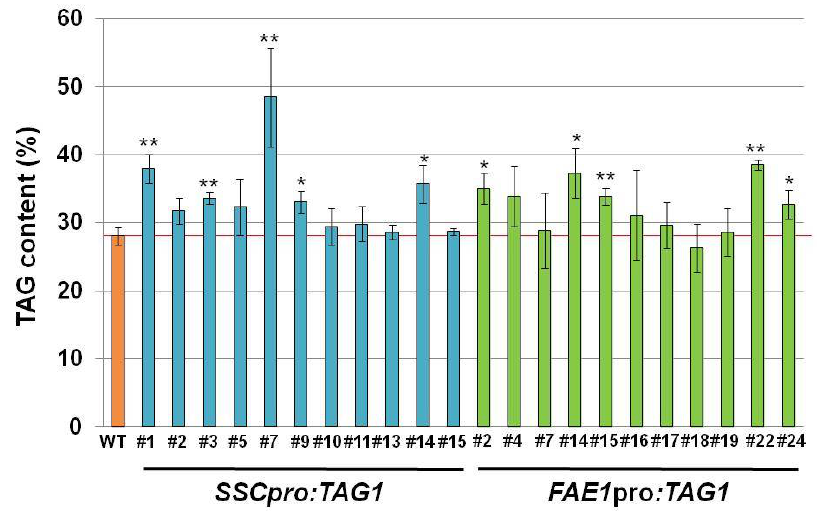
Figure 3. Triacylglycerol (TAG) content in seeds. TAG content in mature seeds from independent transgenic lines expressing AtTAG1 under control of the seed-specific chimeric ( SSC ) promoter or fatty acid elongase 1 ( FAE1 ) promoter. TAG content is expressed as a percentage of mature seed weight. Values are means ± standard deviation of measurements of 3–5 independent experiments. Statistical analysis carried out by Student’s t -test. Asterisks indicate a significant difference between the wild-type (WT) and transgenic lines at p < 0.01 (**) and p < 0.05 (*).